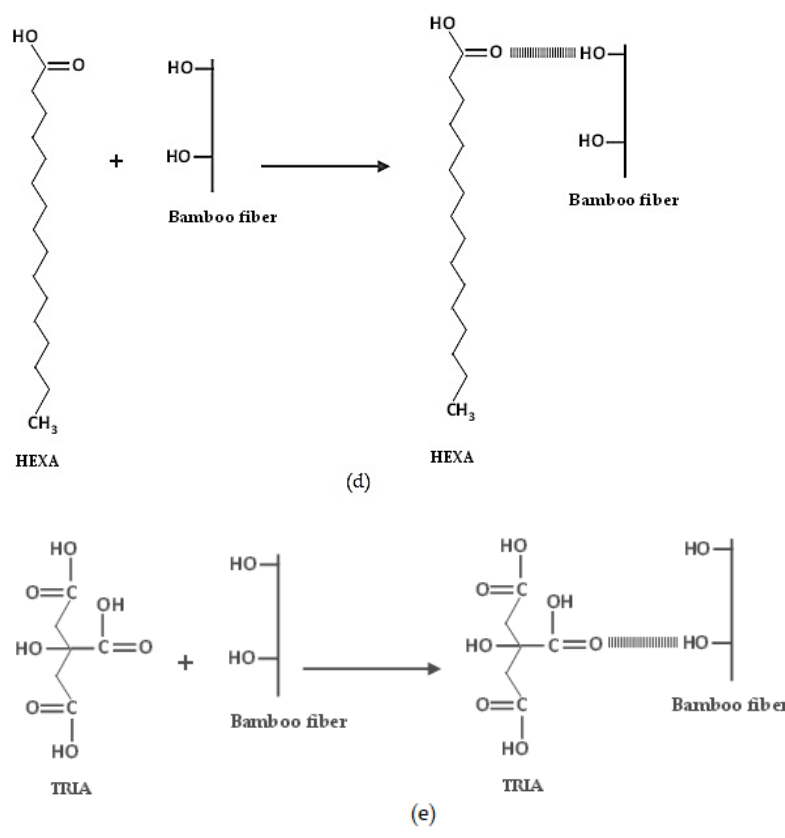
Figure 1. Schematic representation of ( a ) reaction between MAPP and bamboo hydroxyl groups, ( b ) interaction between MAPP and bamboo hydroxyl groups, ( c ) interaction between DODA and bamboo hydroxyl groups, ( d ) interaction between HEXA and bamboo hydroxyl groups, and ( e ) interaction between TRIA and bamboo hydroxyl groups.